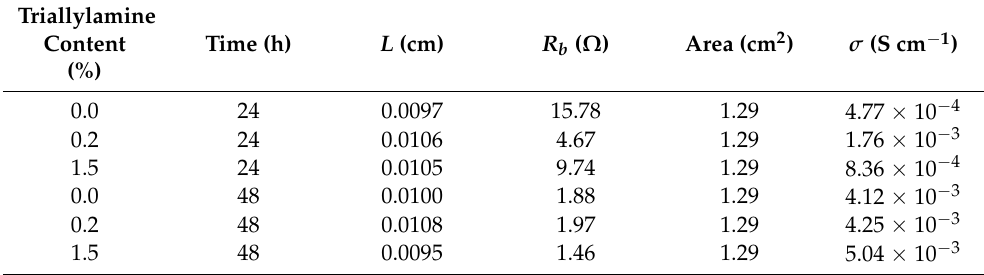
Table 4. Ionic conductivity analysis results of the PBT–EVOH polymer composite electrolyte membranes.